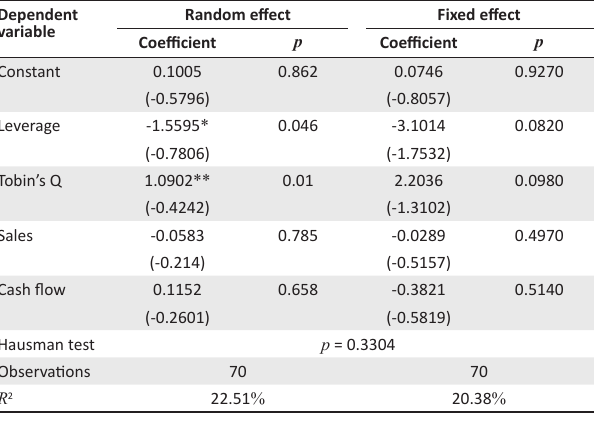
TABLE 6: Regression results for Equation (1) based on a subsample of firms with high growth opportunities. Dependent